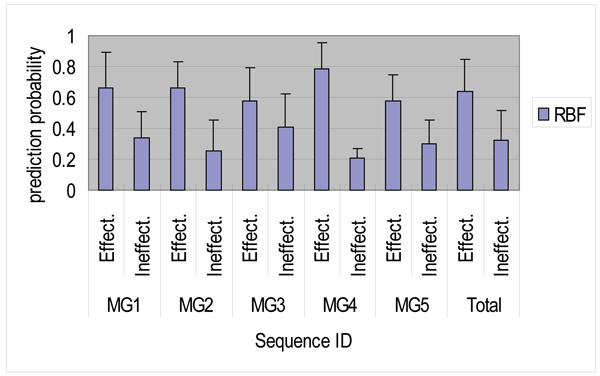
Comparison of the average prediction probabilitiesof the effective ("Effect") and ineffective ("Ineffect") sequences for MG1 to MG5 by the RBF method.